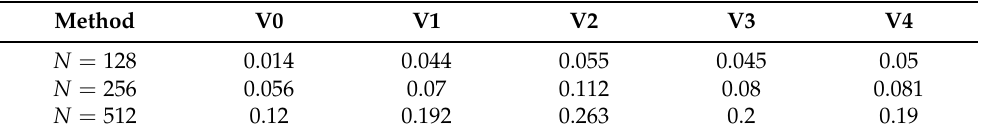
Figure 2. Laplace 2D single-layer. Log-log plots of the errors with respect to (cid:96) made in computing the solution (as described in Figure 1) along the normal of the three points A, B, C, plotted as black × ’s in Figure 1. Table 1. Laplace 2D single-layer. CPU times (in seconds) for various number of quadrature points and representations. Times account for computing the solution at N × 12 grid points ( (cid:96) = 10 − k , k = 0,11 ) on a body-fitted grid. (cid:74) (cid:75)